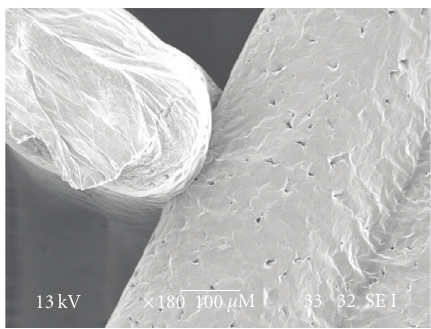
Figure 5: SEM micrograph of filament adhesion